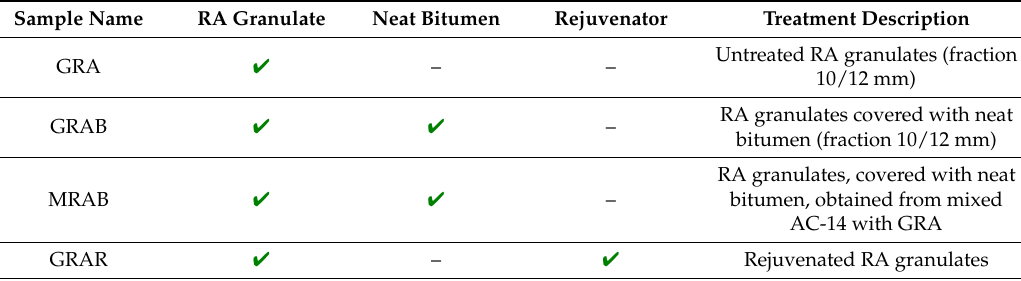
Table 1. Samples and treatment description.